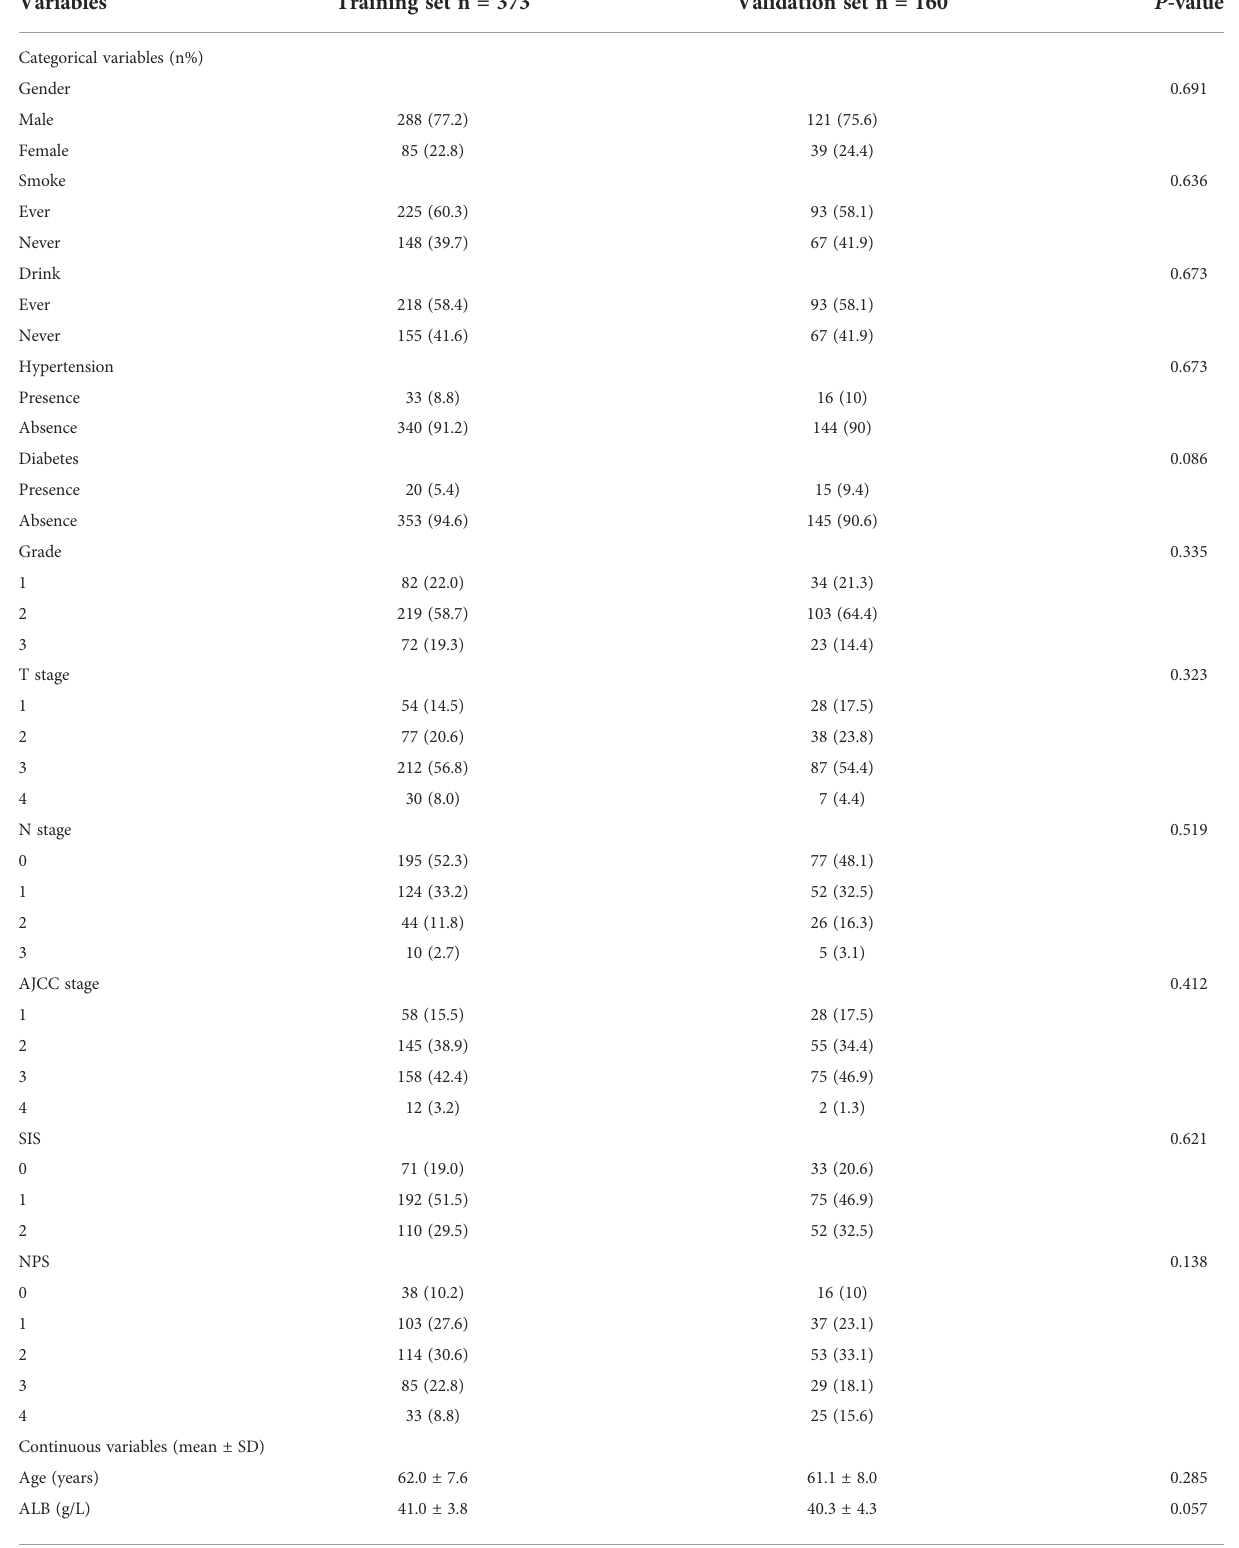
TABLE 1 Demographics and clinical characteristics of patients in the training and validation